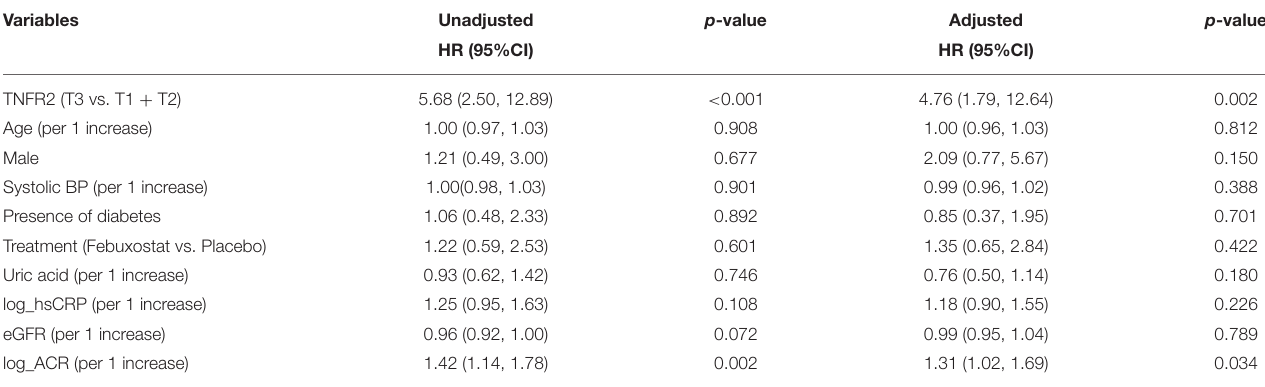
TABLE 3 | Univariate and multivariate Cox regression analyses of the risk factors for 30% eGFR decline from baseline.